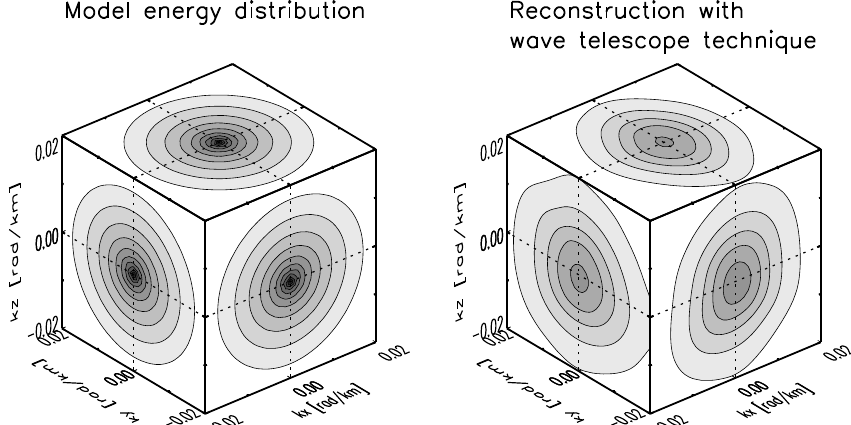
Fig. 2. Comparison of energy distribution in the 3-D wave vector domain. Left panel displays the model distribution from which synthetic data are generated and sampled at four different positions in the spatial coordinate. Right panels displays the energy distribution reconstructed using the wave telescope technique. Adapted from the numerical test of the wave telescope technique in Narita et al. (2010a).